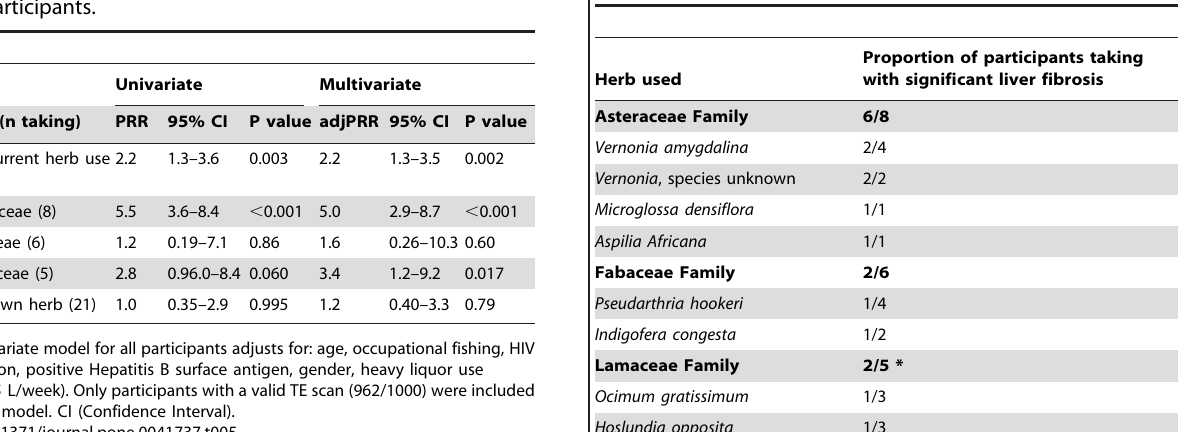
Table 7. Use of specific herbs and significant liver